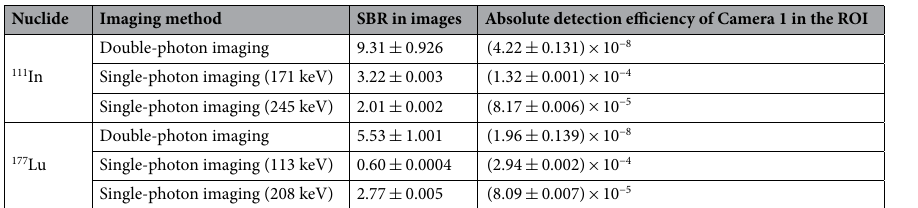
Figure 2. 2D imaging results for 111 In and 177 Lu in the microtubes in one direction. ( a-1 ) Single-photon imaging using 171 keV gamma rays. ( a-2 ) Single-photon imaging using 245 keV gamma rays. The overlaps in the photopeak spectra of 208 and 245 keV mainly contribute to the background (BG) events that make the artifacts in the image. ( a-3 ) Double-photon coincidence imaging. ( a-4 ) 1D plot at the z -pixel = 5. The background in the 177 Lu position is reduced by the coincidence method. ( b-1 ) Single-photon imaging using 113 keV gamma rays. The scattering events of 111 In mainly contribute to the BG events that make the artifacts in the image. ( b-2 ) Single-photon imaging using 208 keV gamma rays. ( b-3 ) Double-photon coincidence imaging. ( b-4 ) 1D plot at the z-pixel = 5. The background in the 111 In position is reduced by the coincidence method. Nuclide Imaging method SBR in images Absolute detection efficiency of Camera 1 in the